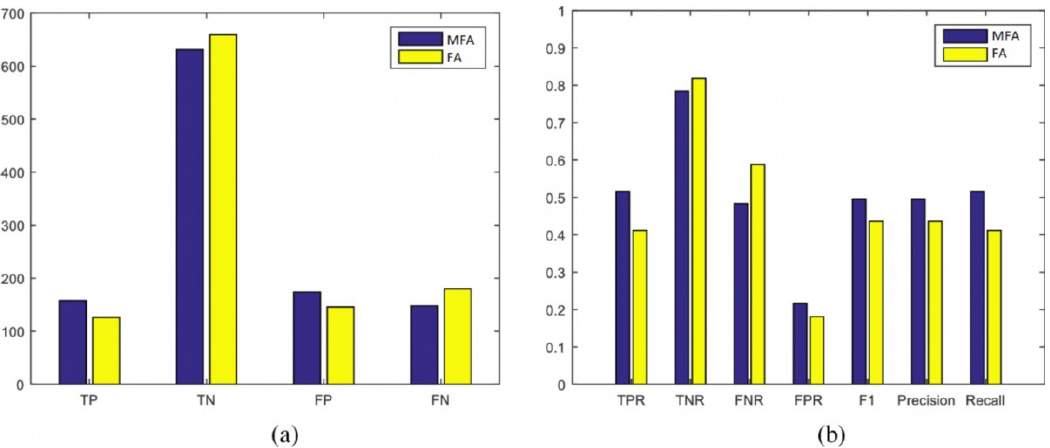
Figure 15. Scenario 4: Statistical evaluation of MFA-OSELM and FA-OSELM using two sets of measures, ( a , b ), for the UJIIndoorLoc dataset.